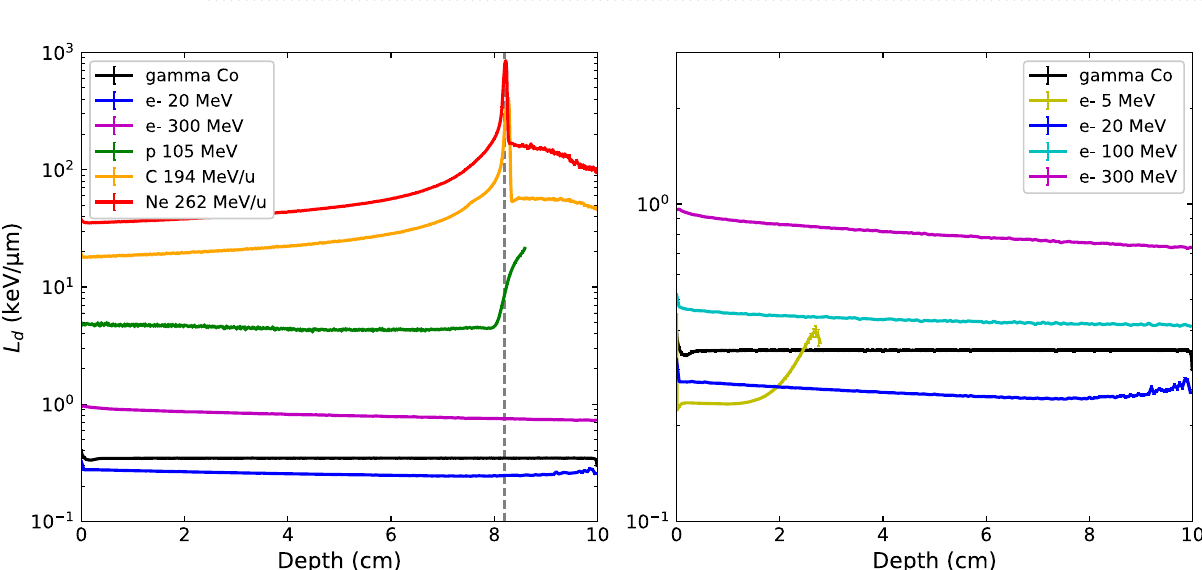
Figure 3. Dose-averaged LET profiles in depth to water for photon, clinical electrons, VHEE and ion beams (left), and details of the L d results for all electron beam energies (right). The vertical grey dashed line marks the Bragg peak position. L d values associated to doses lower than 0.1% of max dose are not shown to keep statistical relevance. Uncertainties on L d values in central axis voxels are less than